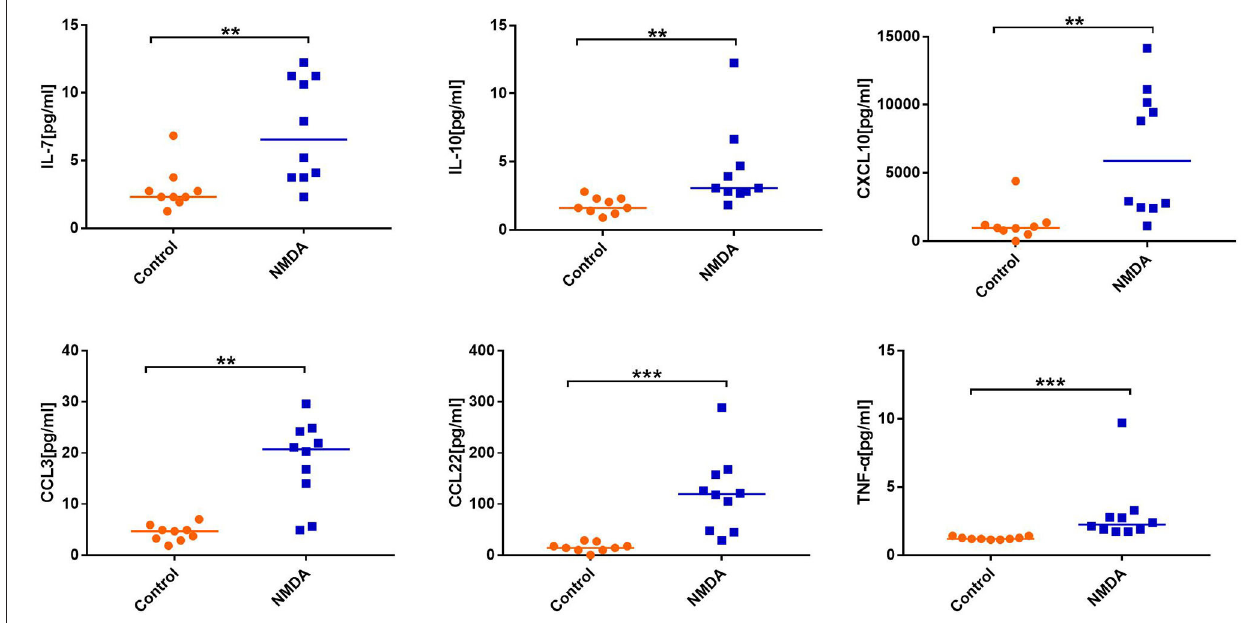
FIGURE 1 | Comparison of the level of cytokines/chemokines between anti-N-methyl-D-aspartate receptor (NMDAR) encephalitis group and control group. Mann–Whitney U test was used. Only cytokines/chemokines that were statistically significantly different and selected for the next experiment are shown. Median cytokine/chemokine levels are indicated. ** P < 0.01, *** P < 0.001. NMDA, anti-NMDAR encephalitis group; Control, control